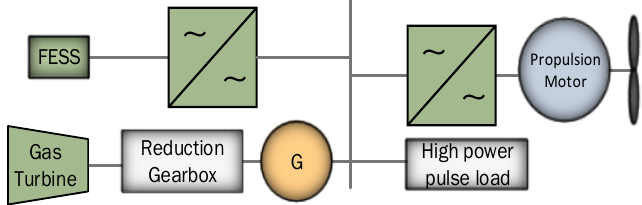
Figure 18. Integration of flywheel energy storage system (FESS) with IPS.